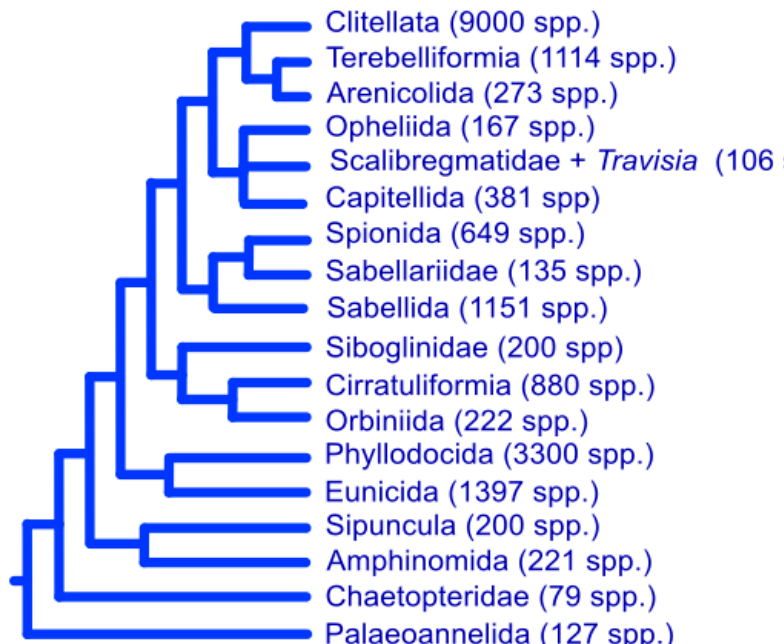
Figure 3. Metatree (based in [88,102]). The estimates for currently valid species were obtained from following studies or experts, although some minor groups are missing in the tree.; Clitellata, Erséus and Martinsson, pers. com. [94]; Terebelliformia [93] ; Arenicolidae [89]; Opheliidae [90] , Salibregmatidae and Travisia [89,90] ; Capitellida [89]; Spionida [103–106]; Sabellariidae [89,107]; Sabellida [99]; Siboglinidae [108] ; Cirratuliformia [89,100]; Orbiniida [95] ; Phyllodocida [101]; Eunicida [91] ; Sipuncula [97] ; Amphinomida